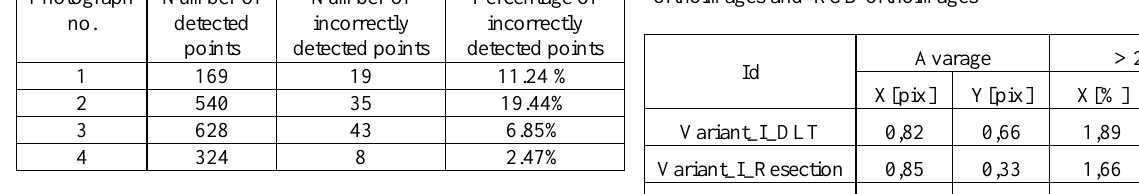
Table 2. Statistic of detected points